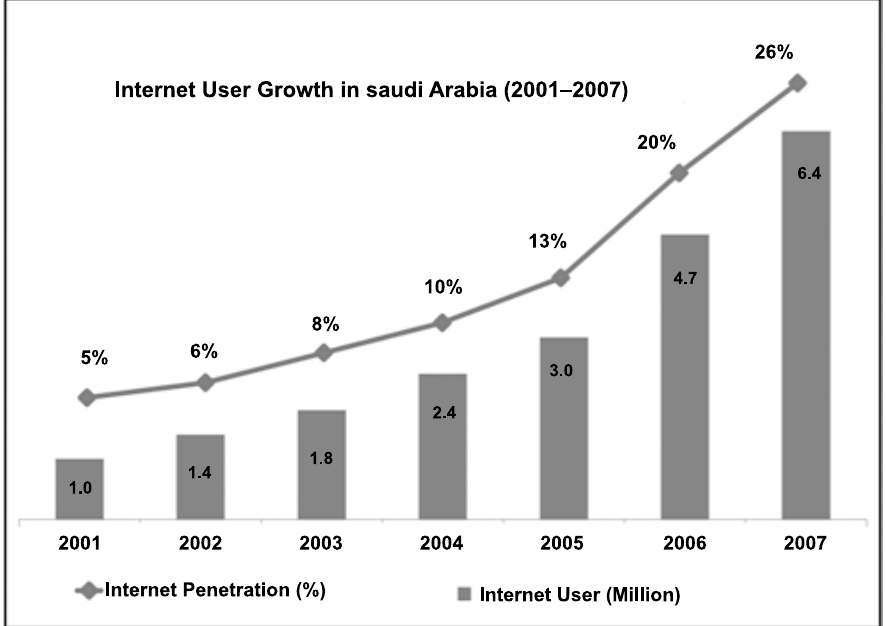
Figure 1. Internet users in Saudi Arabia. Source: